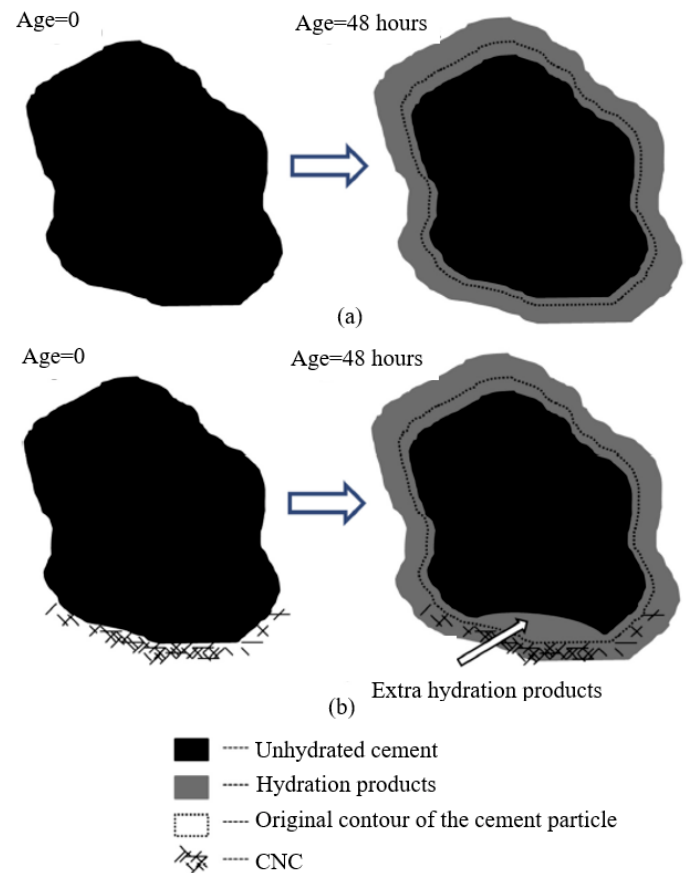
Figure 6. Schematic illustration of hydration products forming around cement particles for ( a ) plain cement pastes and ( b ) cement pastes with CNCs. Reproduced from [50], with permission from Elsevier, 2015.